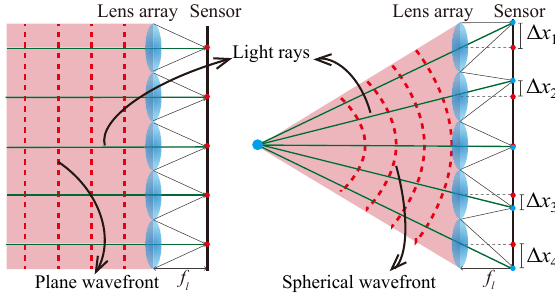
Figure 19. Shack–Hartmann wavefront